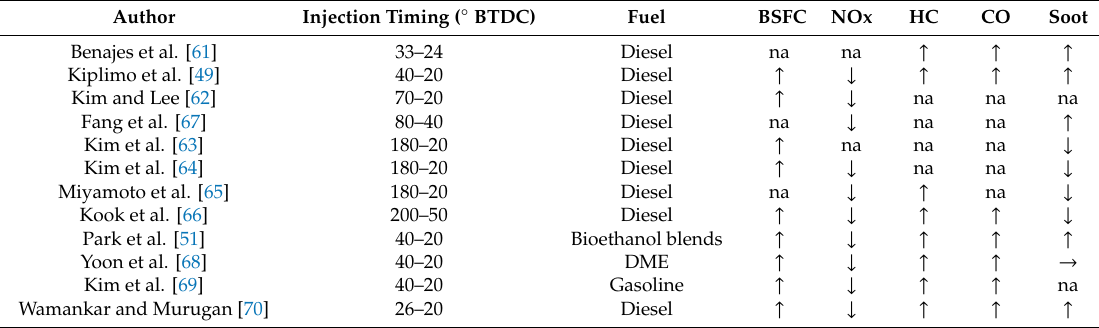
Table 3. Variation of performance and emissions after advancing the early injection timing